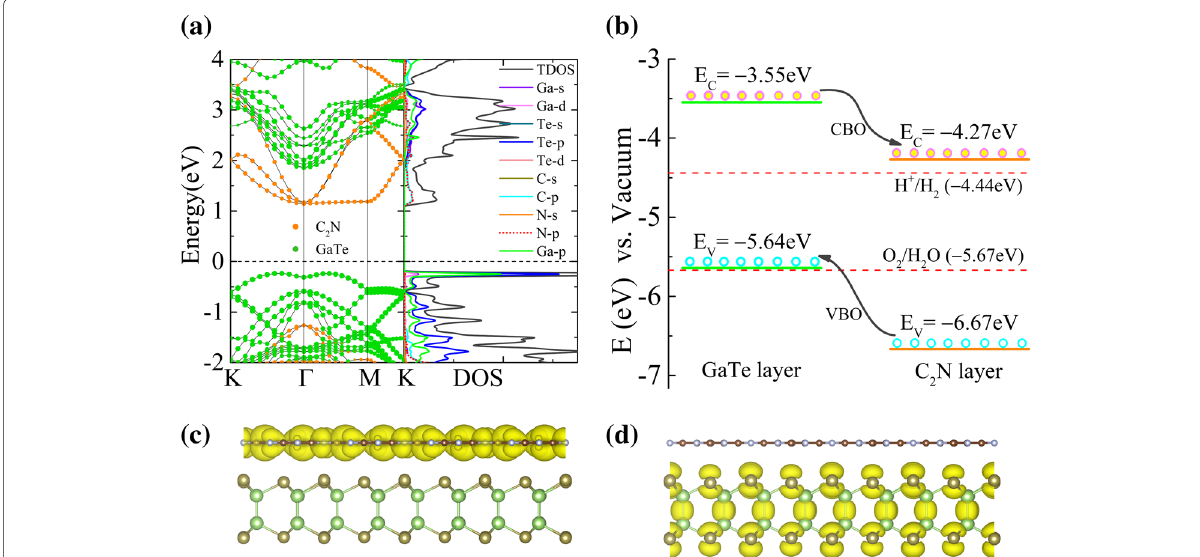
Fig. 2 a The projected band structure of the GaTe/C 2 N heterostructure with γ -stacking configuration and the corresponding total and partial density of states. b Schematic representation of type II band alignments for the carrier transfer and separation in the GaTe/C 2 N heterostructure, referring to the vacuum level. The redox potentials (red dashed line) of water splitting at pH = 0 are shown for comparison. Band decomposed charge densities of the c VBM and d CBM of the